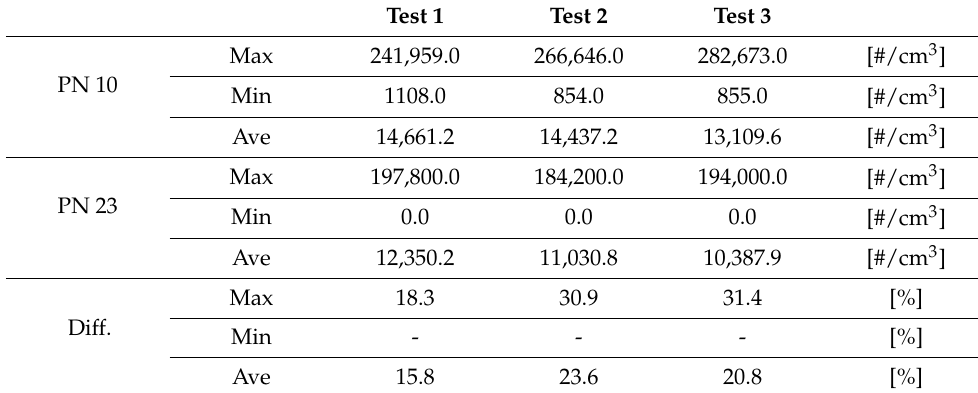
Table 2. Comparing particle count of the with DPF tests.